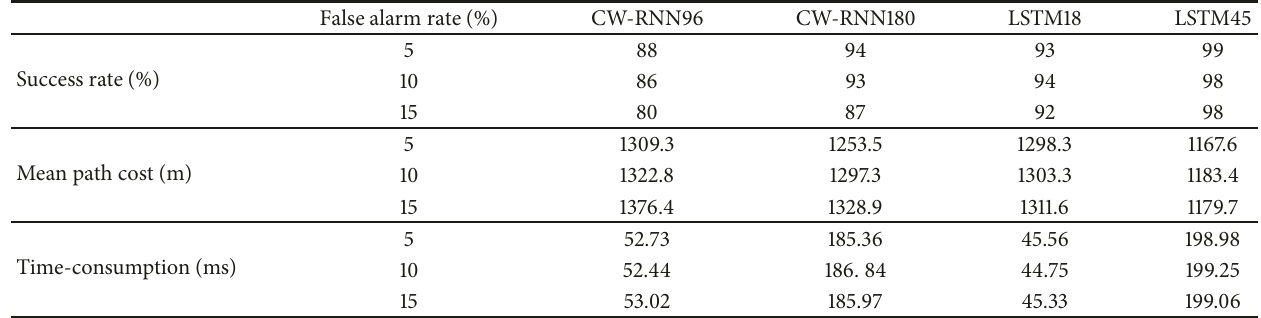
Table 2: The performance of all structures in statistical experiment.